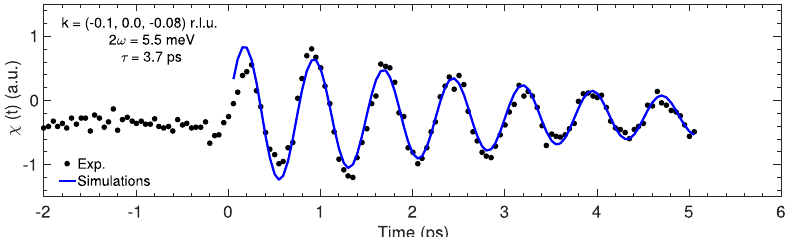
Fig. 4 Comparison of experimental data with simulated χ ( t ) for germanium. Normalized difference intensity of the time-resolved diffuse scattering at k = ( − 0.10, 0.00, − 0.08) r.l.u. is from the experiment presented in ref. 17 (black color), and our simulated χ ( t ) is shown by blue color.